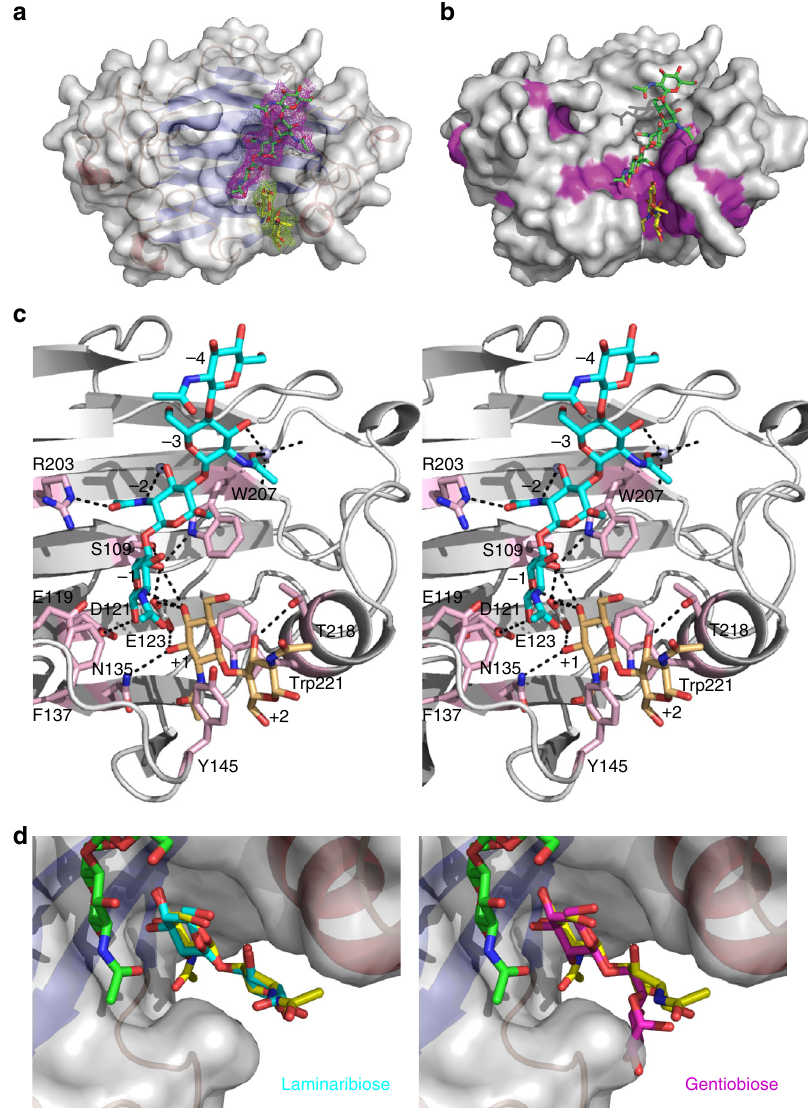
Fig. 3 Crystal structure of Af Crh5 complexed with NAG4 and superposition of laminaribiose and gentiobiose structures on to NAG2-binding site. a Overall fold of Af Crh5 (residues 22 – 275) in complex with NAG4. Protein surface is coloured in grey. Secondary structure elements are coloured red (helices) and blue (strands). Donor NAG4 is shown as sticks with green C α while acceptor NAG2 is shown in yellow C α sticks. The unbiased | F o | − | F c | map (2.25 σ ) is shown as magenta mesh for NAG4 and yellow mesh for NAG2. b Surface representation of conserved residues in A. fumigatus Crh family. Af Crh5 shown in grey surface, residues conserved in other Crh enzymes are coloured in magenta. Donor NAG4 is shown as sticks with green C α while acceptor NAG2 is shown in yellow C α sticks. c Stereoscopic view of the active site of Af Crh5 in complex with donor NAG4 and acceptor NAG2. Donor NAG4 is shown as sticks with cyan C α while acceptor NAG2 is shown in yellow orange C α sticks. Hydrogen bonds are shown in black dashed lines between NAG4, NAG2 and their interacting residues, whose side chains are shown as sticks with light pink C α atoms. d Surface representation of an overlay of the experimentally determined NAG2 acceptor position with a modelled laminaribiose and gentiobiose. The experimentally determined NAG2 acceptor position is shown in yellow C α sticks whereas superposed laminaribiose is shown in cyan C α sticks (left) and superposed gentiobiose is shown in magenta C α sticks